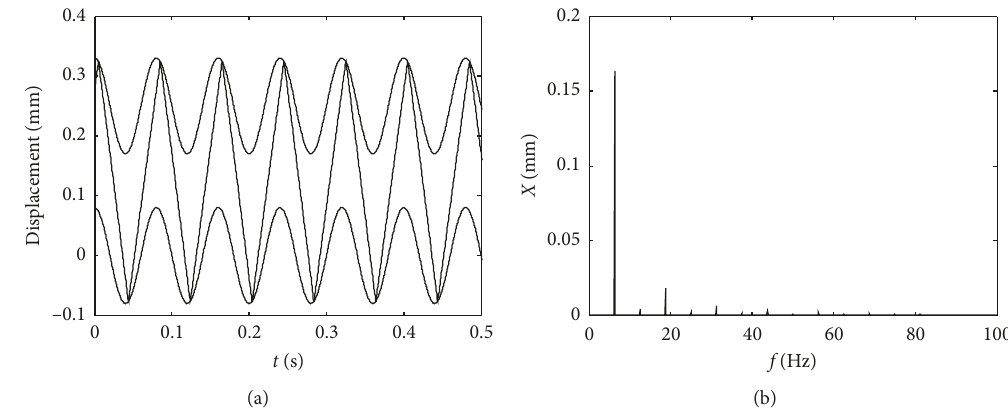
Figure 11: Impact responses when m � 1.5kg. (a) Equivalent displacement. (b) Frequency